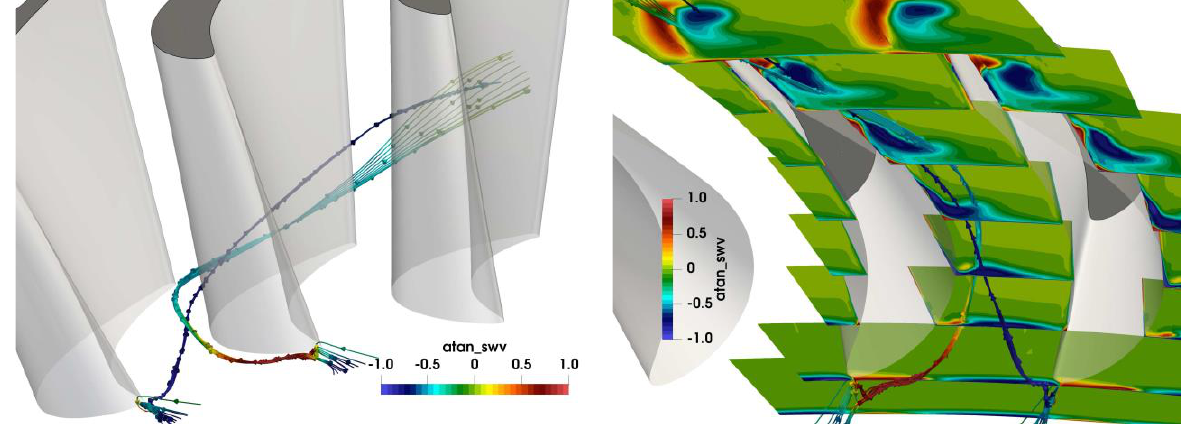
Figure 6. Streamlines and contours of normalized streamwise vorticity in the rotor hub region. The flow in the tip region was dominated by the tip leakage vortex. In Figure 7 (left), the red streamlines coming from the pressure side and passing the tip gap and the blue slightly rotating streamlines coming from the leading edge formed together the tip leakage vortex. The diameter of the vortex increased in the aft section due to a strong backflow region in its center, as depicted in Figure 7 (right). In Figure 7 (middle), additional streamlines coming from the neighboring blade pressure side are turned towards mid-span by the tip leakage vortex, forming a strong counter-rotating vortex, the upper channel vortex. These secondary flows are also well seen in the SWV contours in Figure 8 (left). The tip leakage vortex (blue zone of counter-clockwise vorticity) formed after the leading edge and strongly grew in streamwise direction. The clockwise-rotating channel vortex wrapped around the tip leakage vortex and stretched towards mid-span. Figure 8 (right) shows the secondary flow at the channel outlet. The backflow zone dissolved, and a strong, but smaller, tip leakage vortex can be seen surrounded by the channel vortex.